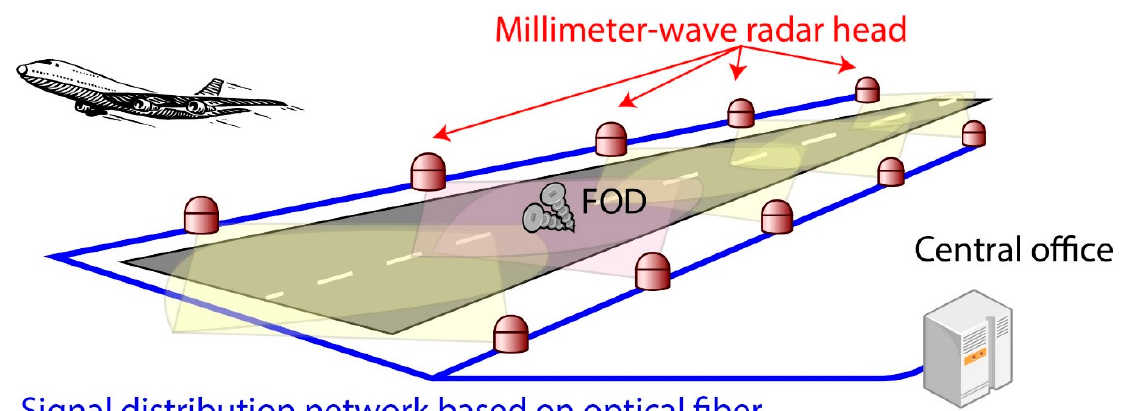
Figure 10. Configuration of a linear cell radar [32].